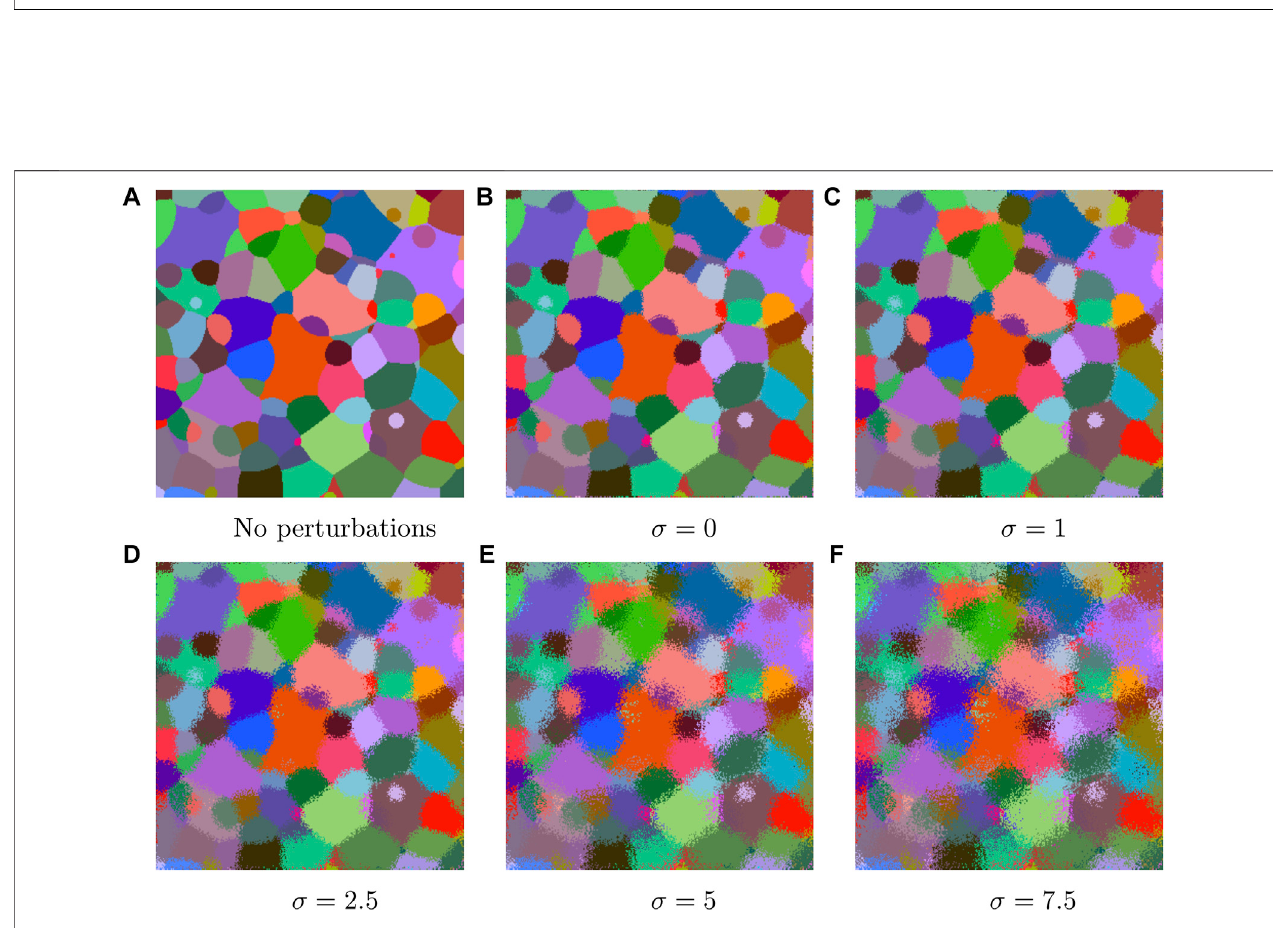
FIGURE 6 | Two-dimensional slices through the simulated image data I sim following perturbation of the latter with I pert , shown in (A – F) for different values of the perturbation spread σ ≥ 0.